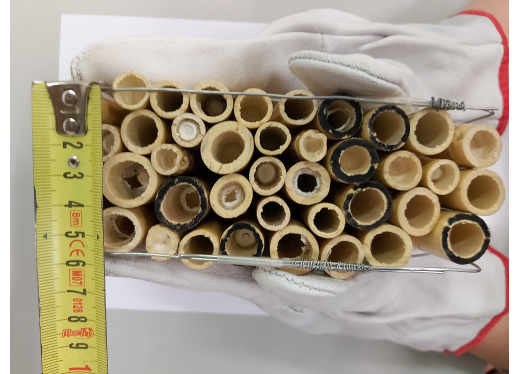
Figure 4. Accommodation of reeds into the